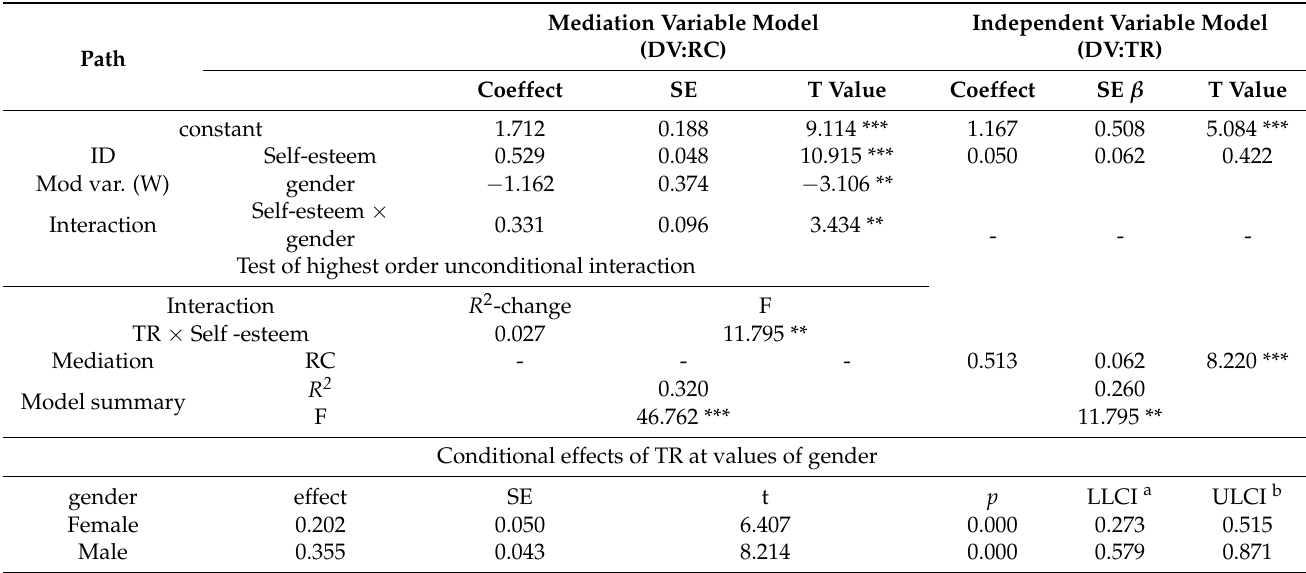
Table 4. Moderated mediation effect of gender on the relation between self-esteem and TR.